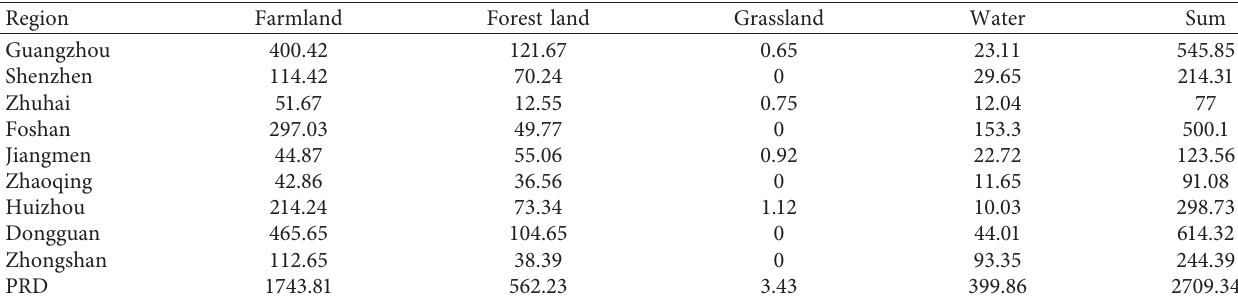
Table 2: Sources of urban expansion land in the Pearl River Delta urban agglomeration during 2008–2015 (km 2 ). Region Farmland Forest land Grassland Water Unused land Sum Guangzhou 56.81 Shenzhen Foshan 60.29 Jiangmen Huizhou